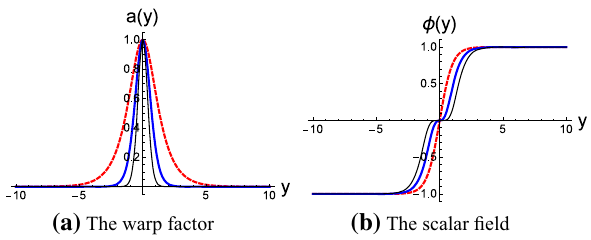
( a ) The warp factor (b) The scalar field Fig. 1 The shapes of the warp factor a ( y ) and the scalar field φ( y ) of the first brane model. The parameters are set as k = 1, v = 1 and n = 1 for the dashed red lines, n = 3 for the thick blue lines, and n = 7 for the thin black lines a the warp factor, b the scalar